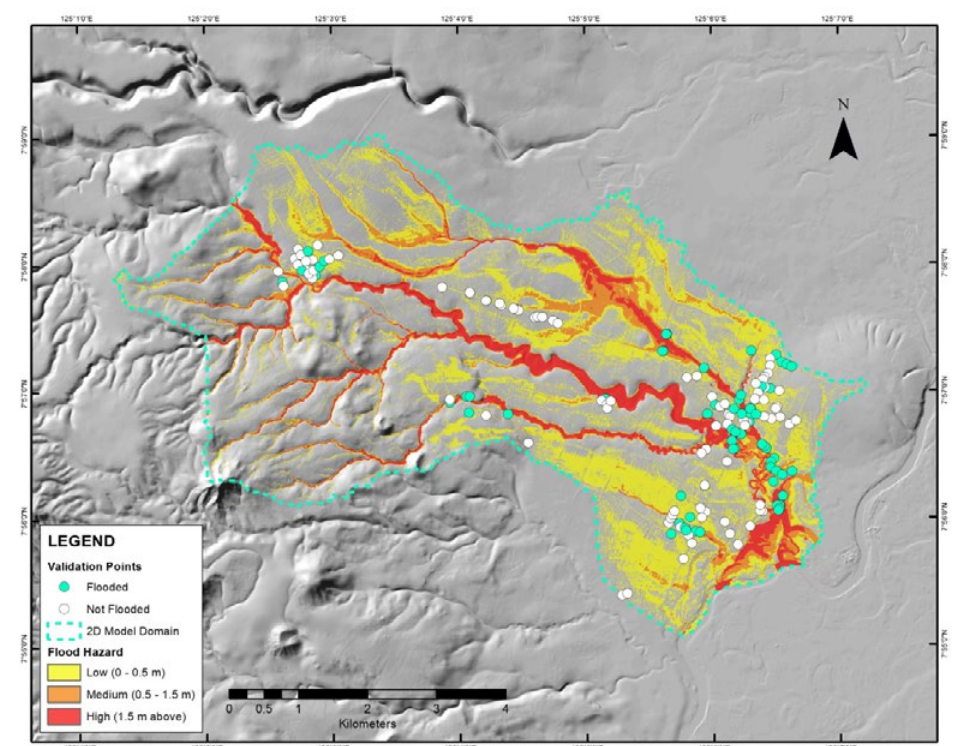
Fig. 8: Flood validation points of Malingon river in tropical storm Sendong flood hazard map